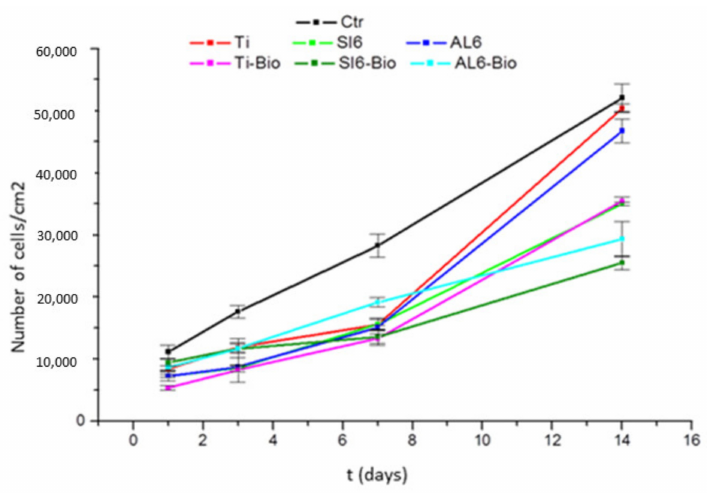
Figure 8. Ctr: control; Ti: titanium cp; Ti-Bio: smooth titanium with sodium titanate; Si6 sandblasting with SiC; Al6 sandblasting with Al 2 O 3 ; and Al6-Bio: sandblasting with alumina and sodium